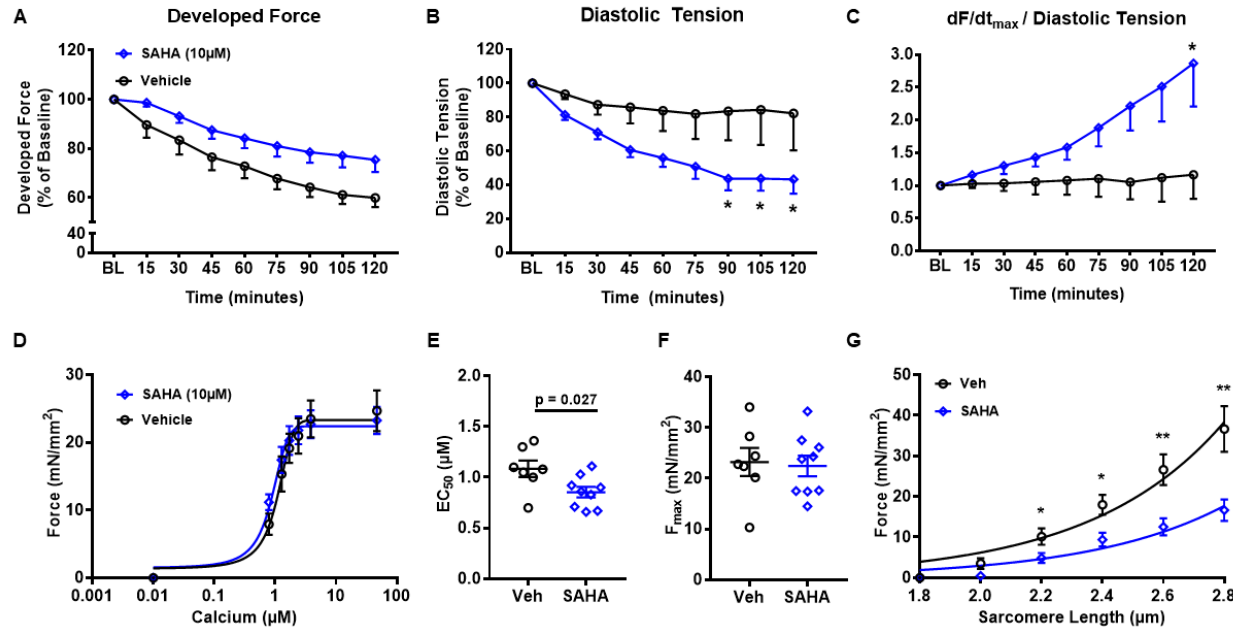
Figure 4. Effect of acute SAHA treatment on human trabeculae. Trabeculae were isolated from biopsies of non-failing human LV. There was an increase in ( A ) developed force and decreased ( B ) diastolic tension with SAHA treatment, with an increase in ( C ) dF/dt max /diastolic tension; n = 5–13 trabeculae per parameter from 7 patients. Myofilaments were isolated from human LV trabeculae. There was a slight left shift in the ( D ) average force-calcium curve with SAHA treatment. SAHA-treated samples had a reduction in ( E ) EC 50 , indicating an increase in myofilament calcium sensitivity but no difference in ( F ) F max ; n = 7 control myocytes from 3 patients, 9 SAHA from 3 patients. SAHA-treated samples had a decrease in ( G ) passive stiffness at increasing sarcomere lengths; n = 7 myocytes from 3 patients in each group. For trabeculae functional experiments ( A – C ), repeated measure two-way ANOVA was performed. For the myofilament functional experiments (D-G), analysis was performed using a two-sided Student’s t -test. * p < 0.05, ** p < 0.01. Data shown are means ± SEM.